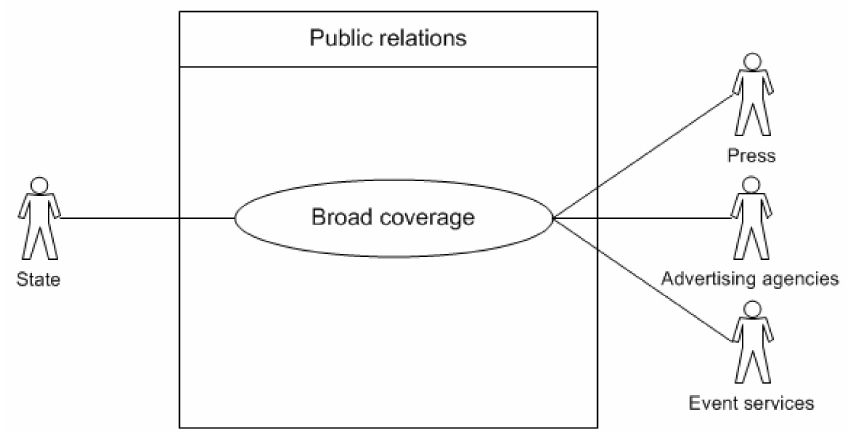
Figure 6. Media coverage of the